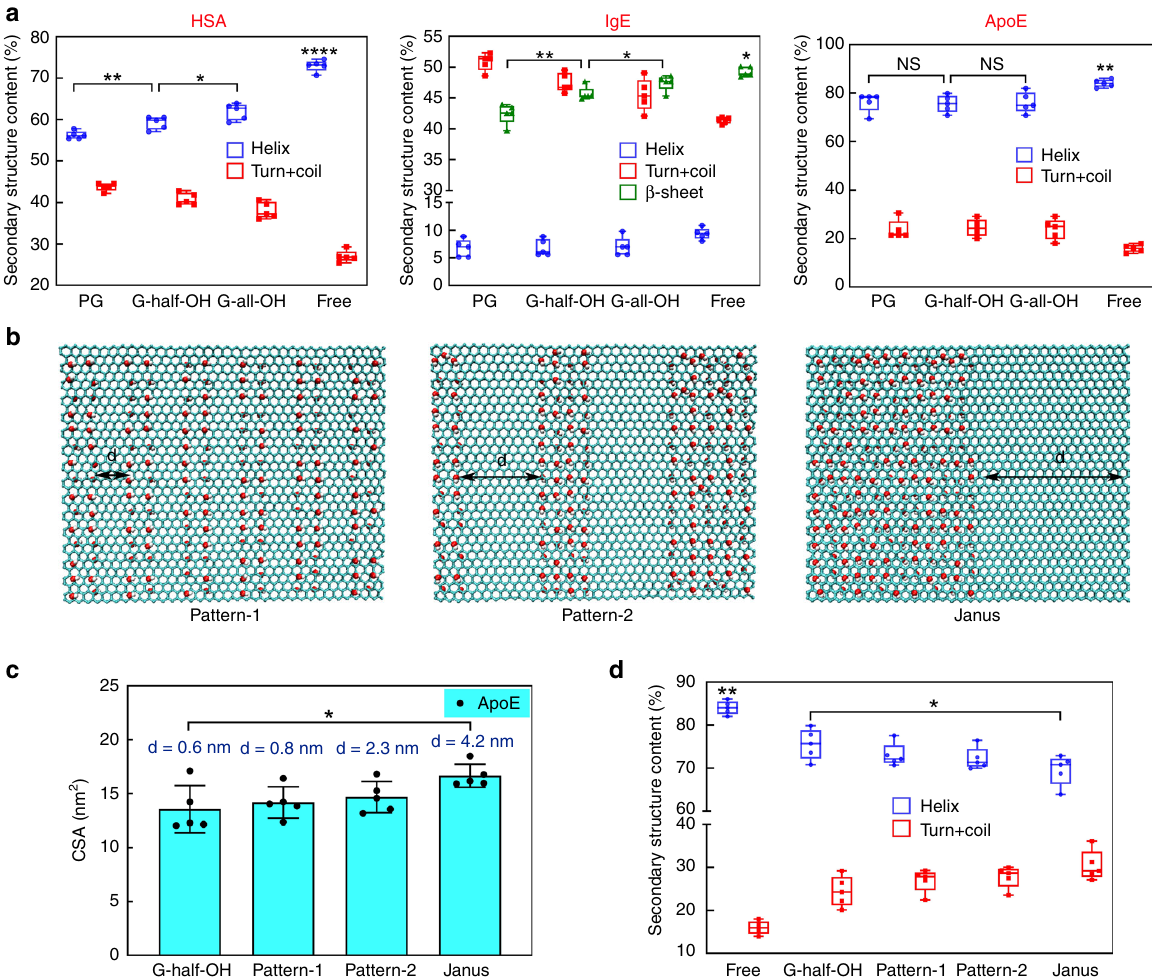
Fig. 5 Structural pro fi les of adsorbed proteins. a Secondary structure content of different proteins on the graphene after 200 ns MD simulation (Free: the secondary structure content of the proteins in the water). Data are presented as mean ± s.e.m. ( n = 5). b Schematic illustration of three new designed graphene sheets (Janus, pattern-1 and pattern-2) in the simulation: they have the same number of hydroxyl groups as G-half-OH, whereas the modi fi ed area (modi fi ed with hydroxyl groups) and the unmodi fi ed area (pristine graphene) are distributed at intervals, the distance of the interval (de fi ned as d) is about 4.2, 2.3, and 0.8 nm, respectively. c , d The CSA and the secondary structure content of ApoE adsorbed on the different sheets, respectively. Data are presented as mean ± s.e.m. ( n = 5). In the box plot, the upper and lower quartile as outlined by top and bottom boundary were divided by line showing the median value. p Values were calculated using multiple t tests (**** p < 0.0005, ** p < 0.01, * p < 0.05, and NS stands for statistically insigni fi cant